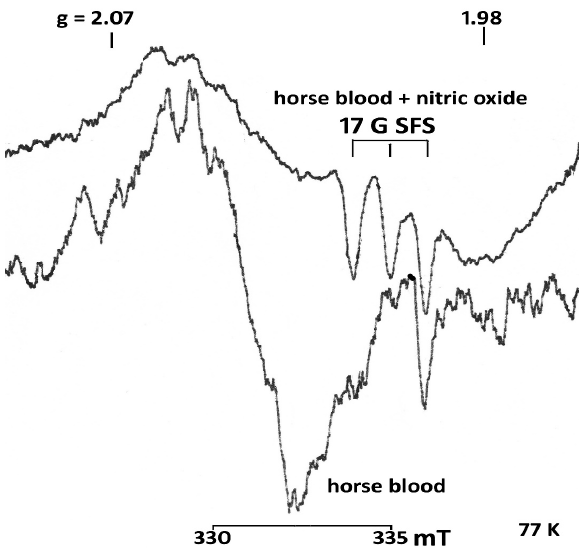
Figure 4. EPR spectra of blood of a healthy horse and blood treated with gaseous nitric oxide (horse blood + nitric oxide (NO)). The blood of a healthy horse contains nitrosylhemoglobin (0.2 ± 0.9 μM). The blood was treated with nitric oxide in the concentration 12.3 ± 0.3 μM. SFS—super fine structure Registration conditions as above. Amplifcation horse blood + nitric oxide (NO)−2 × 105, 4 scans, horse blood −1 × 105, 1 scan. T = 77 K.